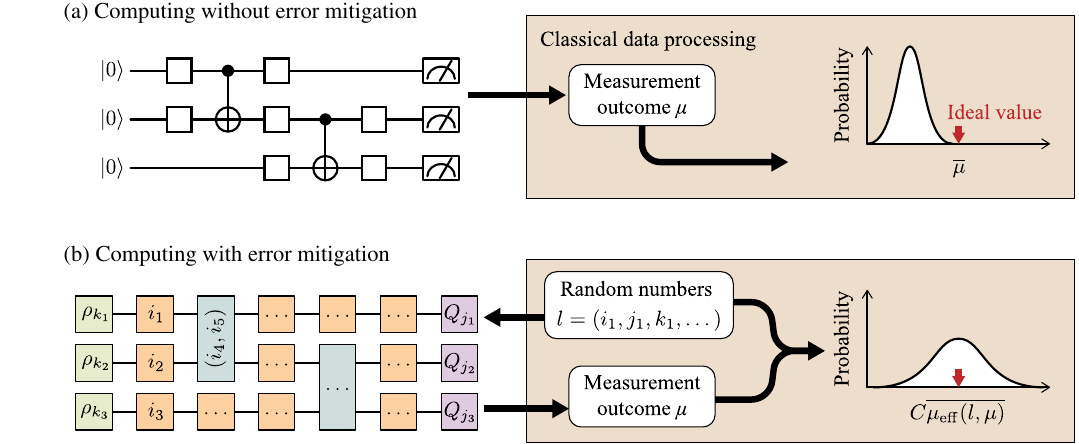
FIG. 1. Quantum computing of the expected value of an observable (a) without quantum error mitigation (QEM) and (b) with QEM. In QEM circuit (b), each operation (including the memory operation) in the original circuit (a) is replaced by an operation depending on the corresponding random numbers [see Fig.